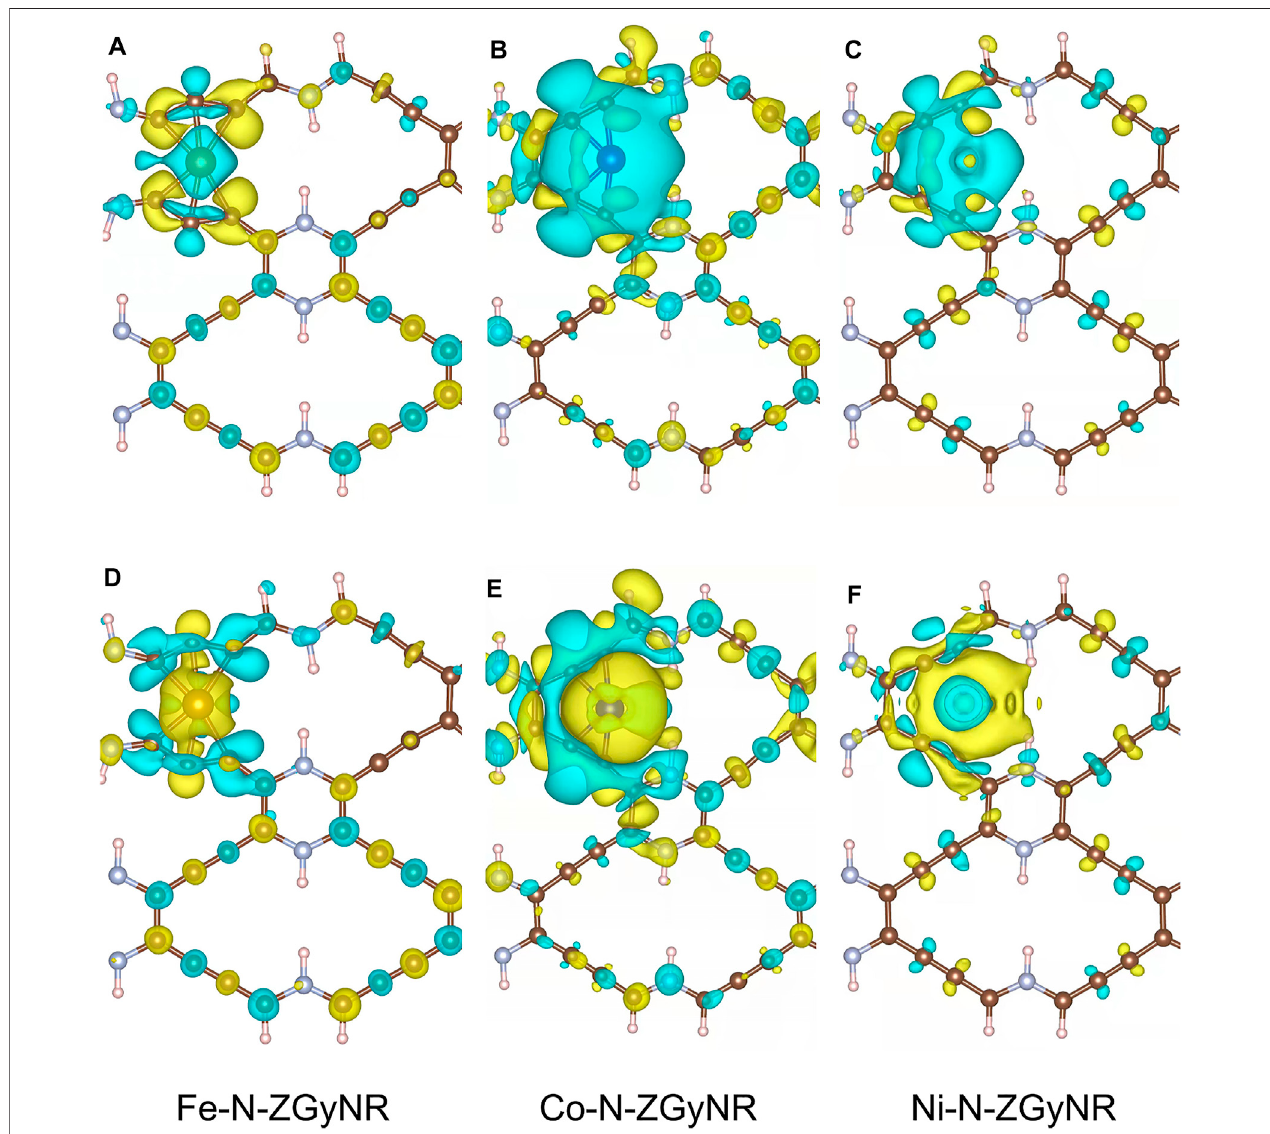
FIGURE 4 | The spin-up (A – C) /spin-down (D – F) electron density difference of M-N-ZGyNR (M = Fe,Co,Ni). The increase (decrease) of the spin electron magnetic moment is represented by the yellow (light blue) region. To make the comparison clear, the isosurface levels of Fe-N-ZGyNR, Co-N-ZGyNR and Ni-N-ZGyNR are set to 2 × 10 − 3 e/Å 3 , 2 × 10 − 4 e/Å 3 and 8 × 10 − 4 e/Å 3